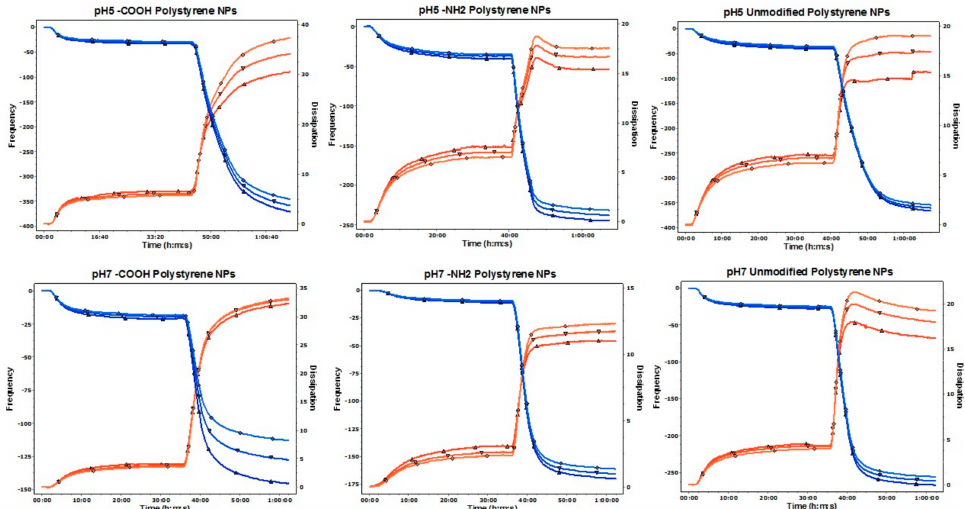
Figure 2. Representative traces for frequency f and energy dissipation D recorded by the QSoft sofware at three diferent overtones (fifth, seventh, and ninth). Frequency is represented as a blue line and its values shown in the left axis. Dissipation is represented as a red line and its values are shown in the right axis.